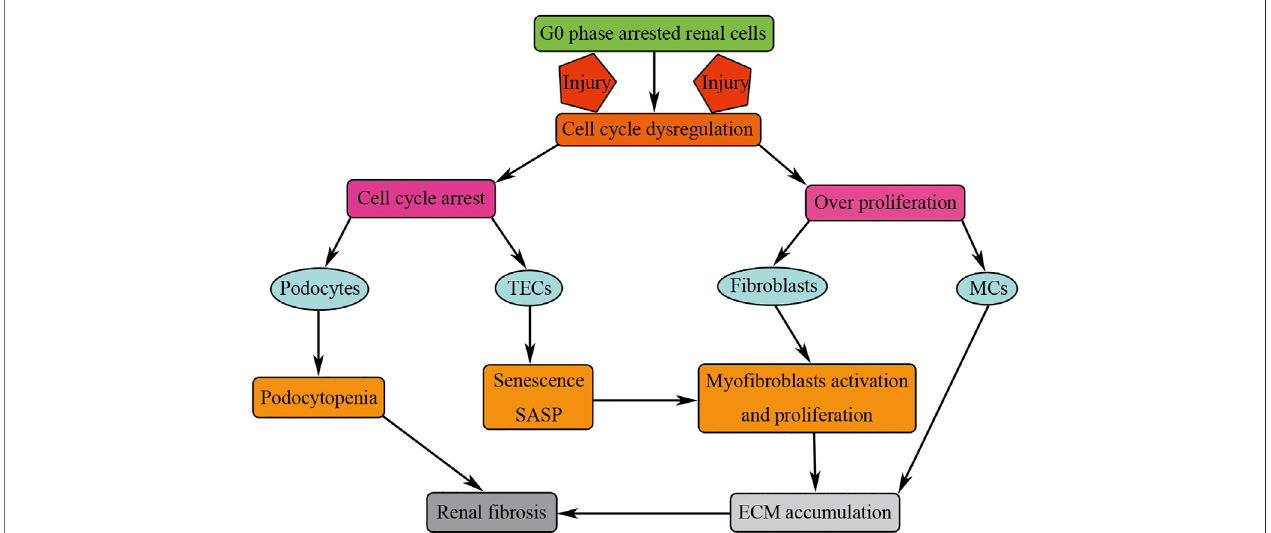
FIGURE 7 | Cell cycle dysregulation of renal cells results in renal fi brosis. Injuries result in cell cycle dysregulation manifested as cell cycle arrest (podocytes and TECs) or overproliferation ( fi broblasts and MCs). Cell cycle arrest or overproliferation ofrenal cells results in renal fi brosis by podocytopeniaand consistent accumulation of